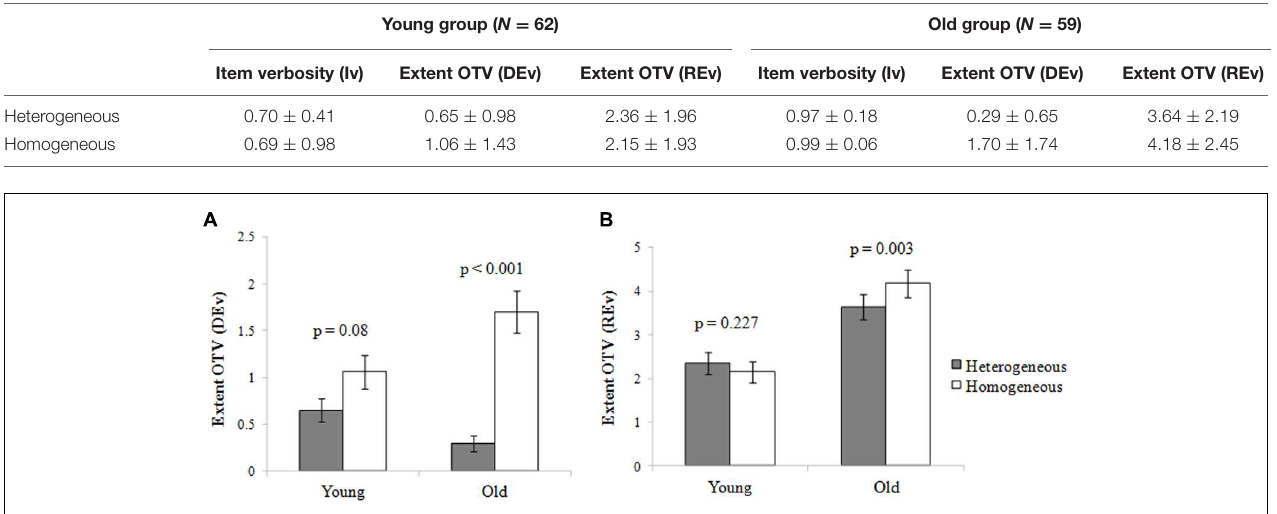
FIGURE 3 | The role of deletion and restraint functions in the age-related OTV: The interaction between age and homogeneity in the extent of OTV (A) that reflected the deletion function (DEv) and (B) that reflected the restraint function (REv) in Experiment 2. It shows the mean extent of OTV scores for the individuals. Error bars represent standard errors of the